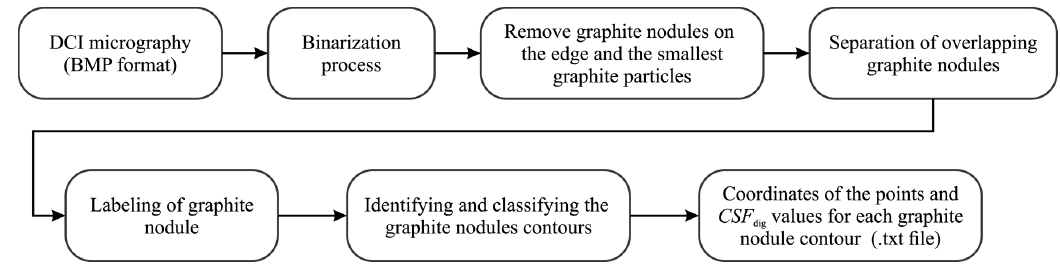
Figure 4. Steps followed to extract the graphite nodule contours.